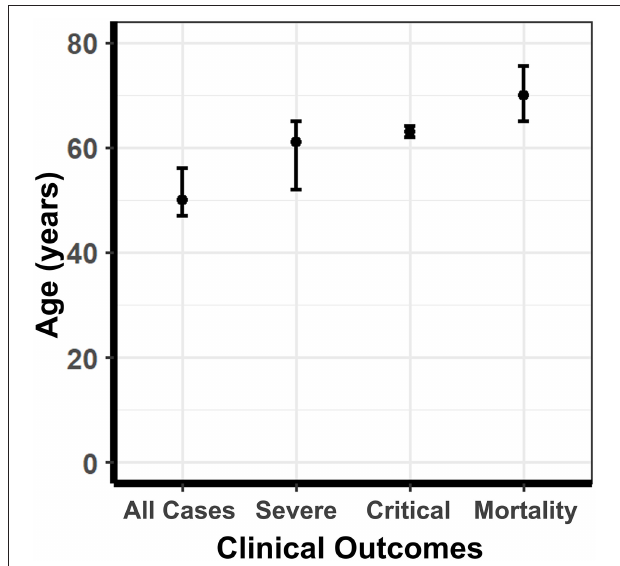
FIGURE 7 | The median age of COVID-19 patients stratified according to disease severity. The median age of COVID-19 patients in all cases, severe cases, critically ill cases, and mortalities. Error bars represent 95% confidence intervals of the median. The median age for all COVID-19 cases was 50, severe cases was 61, critically ill cases was 63, and mortality was 70. A Kruskal-Wallis ranked-sum test conducted on the medians showed that age was significantly different amount the COVID-19 disease severity groups (chi-squared = 24.07, df = 3, p = <